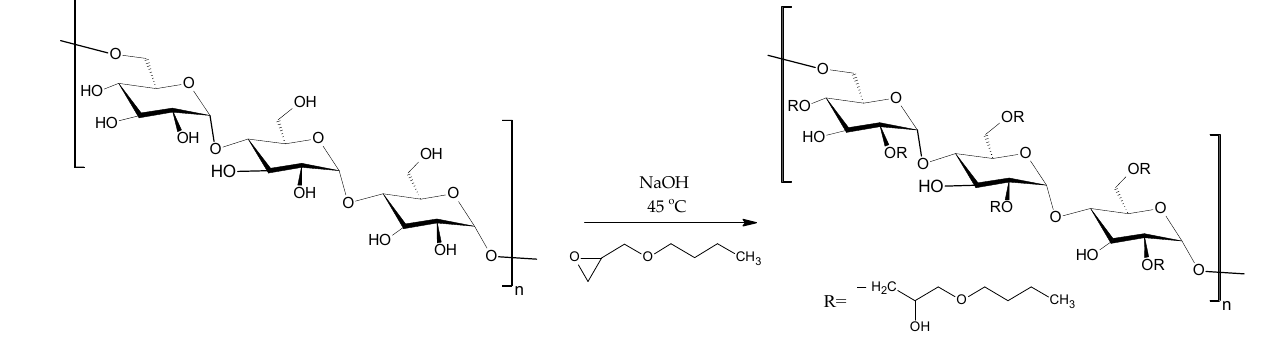
Figure 2. A schematic of the synthesis of grafted pullulan (BMO-PUL). The lyophilised products were acquired as low-density, white cotton-like materials (yield 81–84%), with the chemical modification being verified by 1 H- and 13 C-NMR, as well as FTIR spectroscopy. The Mw was in the range 100–136 kDa, as analysed by gel permeation chromatography (GPC). In the 1 H-NMR spectra of BMO-PUL (Figure 3a), the peaks of pullulan backbone protons appeared over the spectral range δ 3.3–5.4 ppm; 3.3–4 ppm assigned to proton signals at C 2–6 , whilst 5–5.4 ppm was assigned to anomeric protons [11]. The signals recorded at δ 0.9, δ 1.3, and δ 1.5 ppm (denoted as peaks 3, 2, and 1 in Figure 3, respectively) were indicative of the existence of the hydrophobic alkyl chain groups [38]; other protons signal assignments are presented in Figure 3a. The 13 C-NMR spectrum concurred with the 1 H-NMR data, with alkyl chain carbons detected at δ = 14, 19, 31, 44, 51, and 71 ppm, as displayed in Figure 3b. The 13 C-NMR spectrum of the BMO reagent is recorded in Figure S1, Supplementary Materials. Other significant peaks in the 13 C-NMR